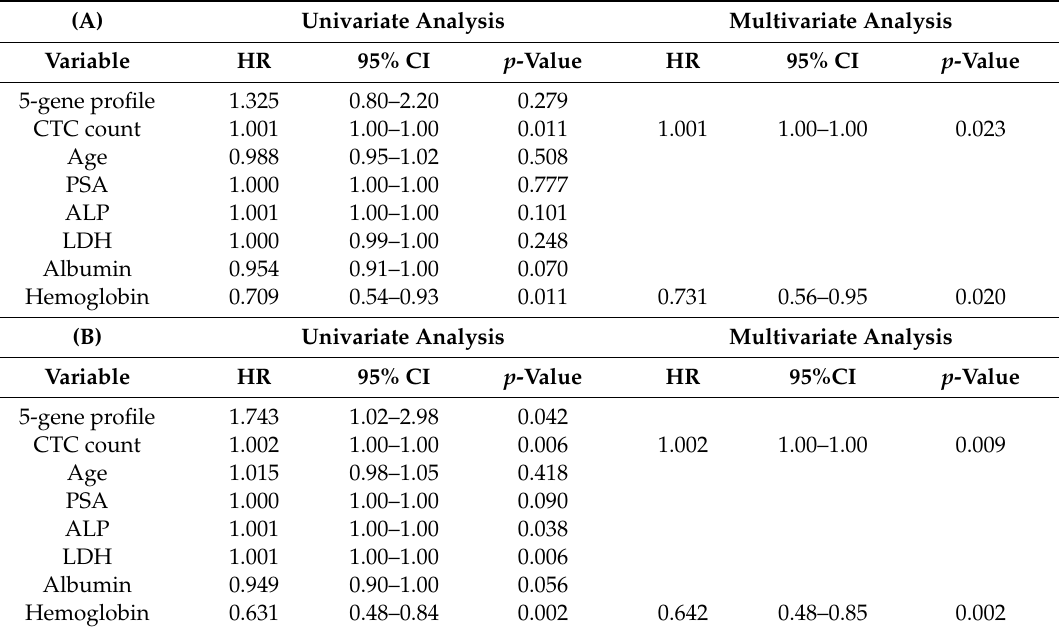
Table 2. Cox Regression analysis ( n =